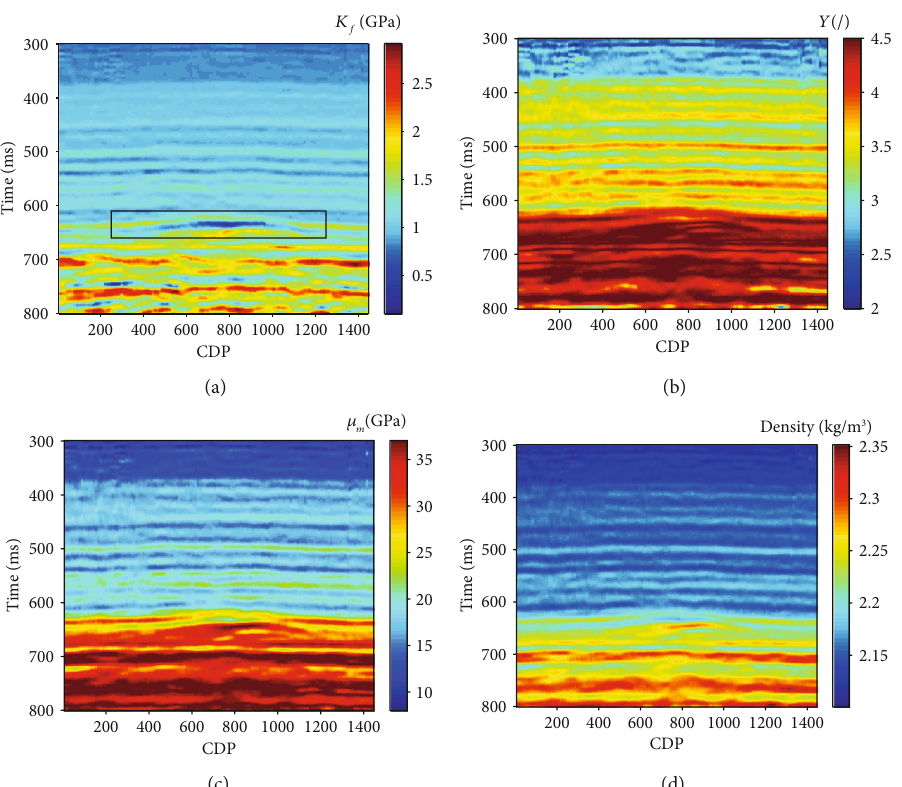
Y , (c) μ f , (b) m , and (d) density. The black rectangle in (a) represents the target